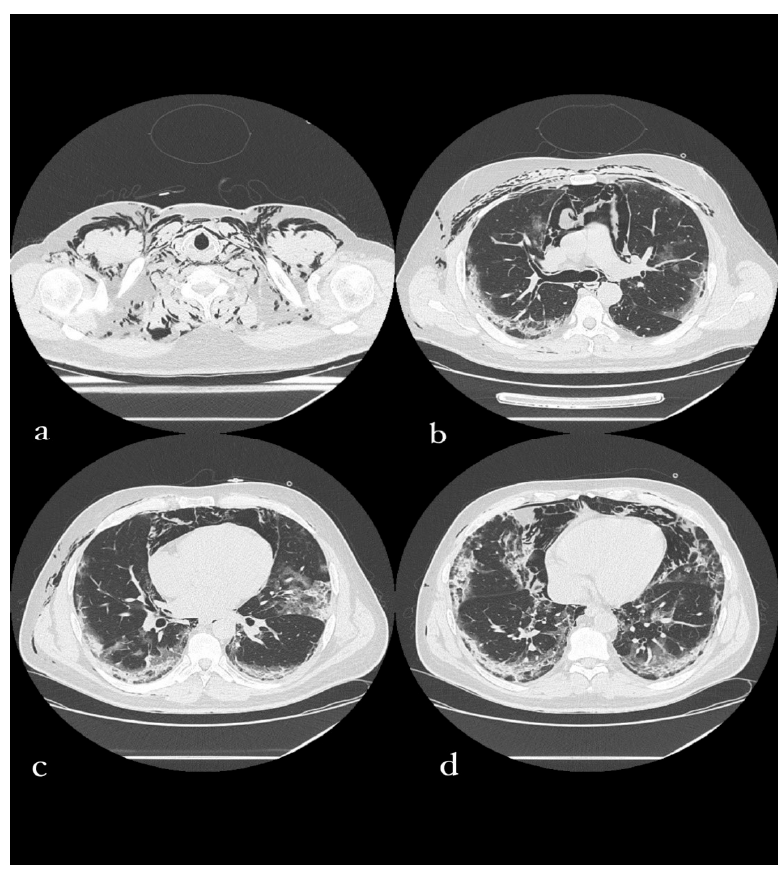
Figure 6. A 49-year-old male patient in whom massive invasive ventilation resulted in the formation of pneumomediastinum. The formation of pneumomediastinum is due to traumatic rupture of the alveoli (caused by invasive ventilation), a phenomenon known as the Macklin effect. Subcutaneous emphysema can also be